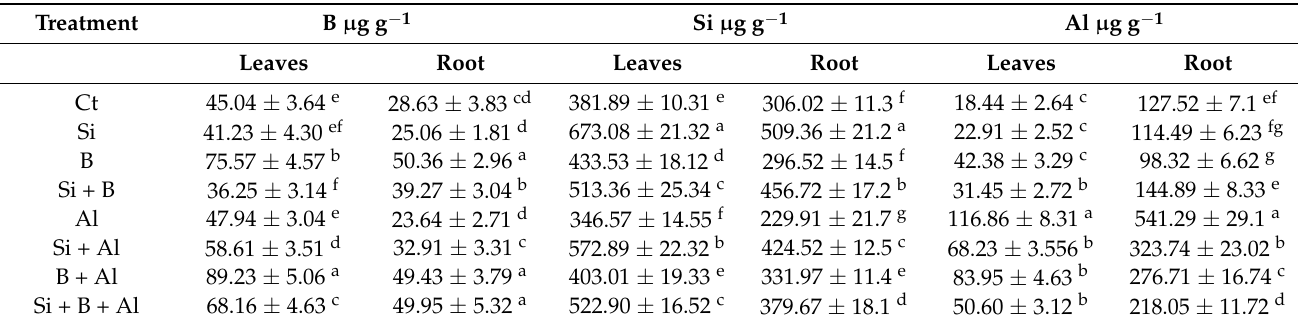
Table 2. The accumulation and uptake of B, Si, and Al + by the roots and shoots of date palm under aluminum